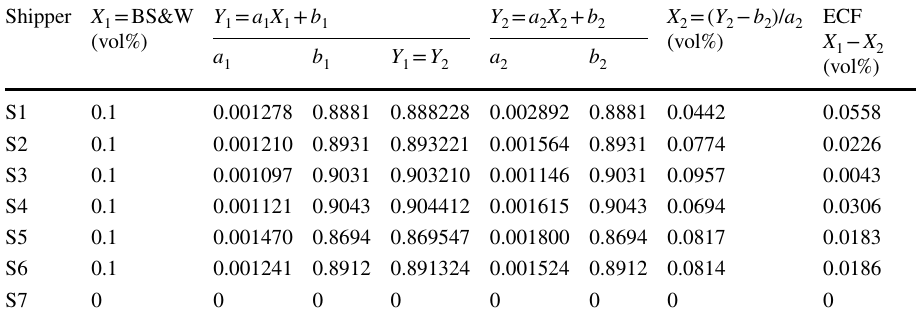
Table 2 Emulsion parameters